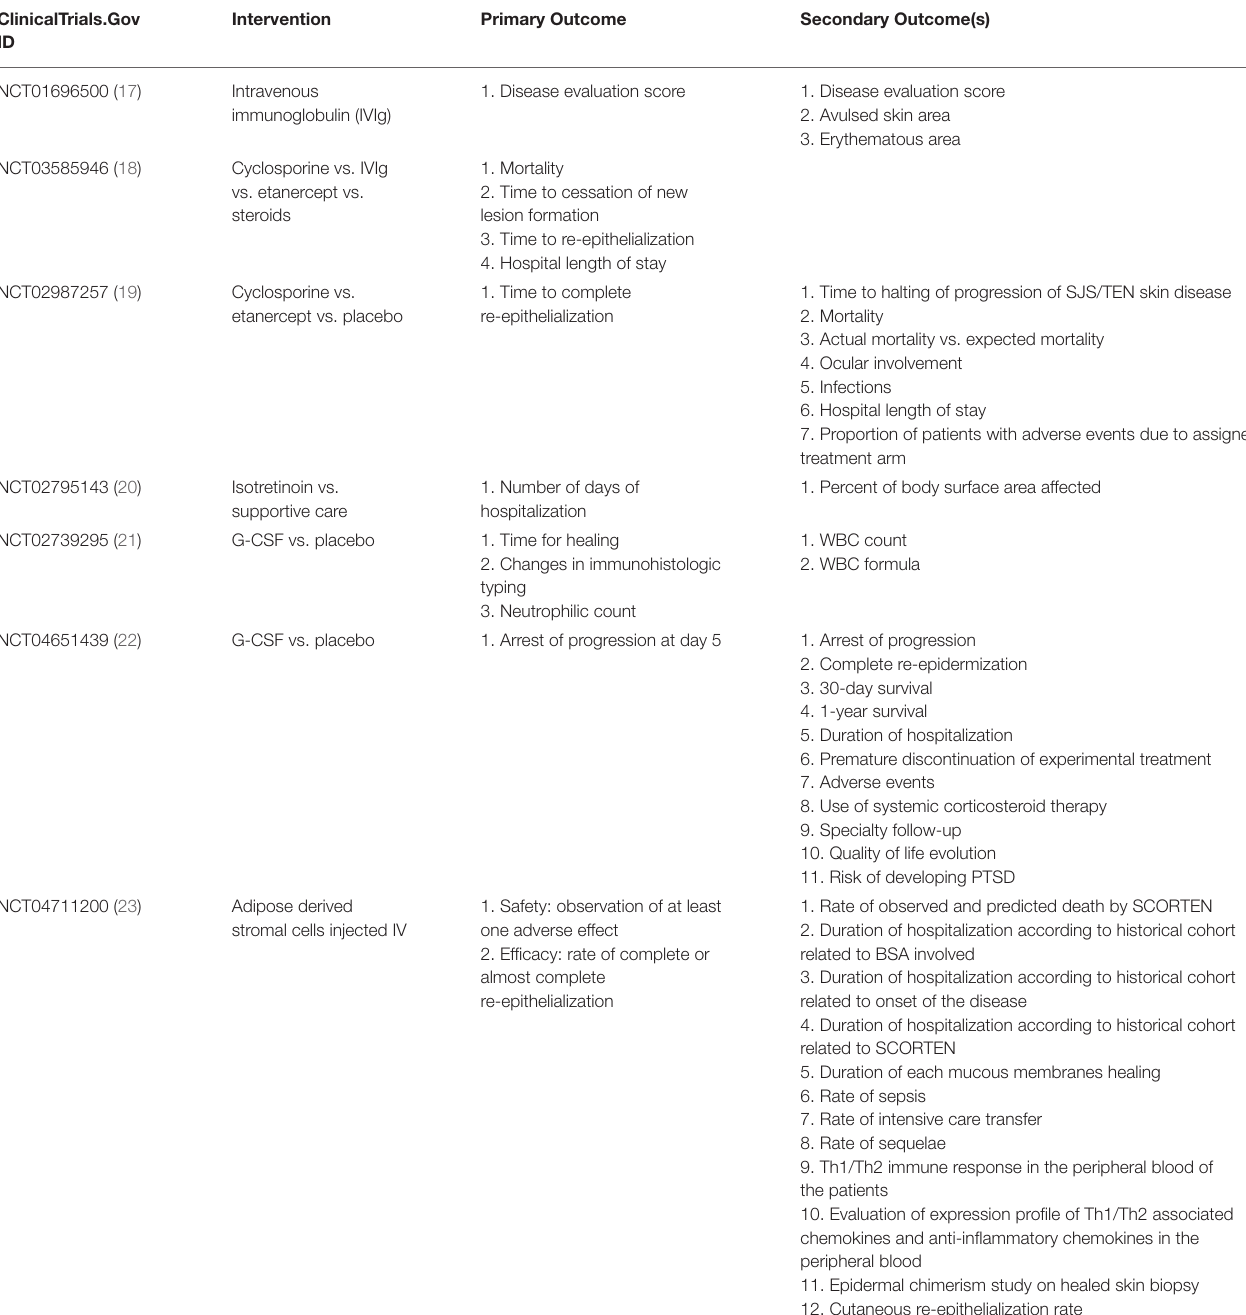
TABLE 2 | Endpoints in trials registered at ClinicalTrials.Gov for epidermal necrolysis interventions. ClinicalTrials.Gov